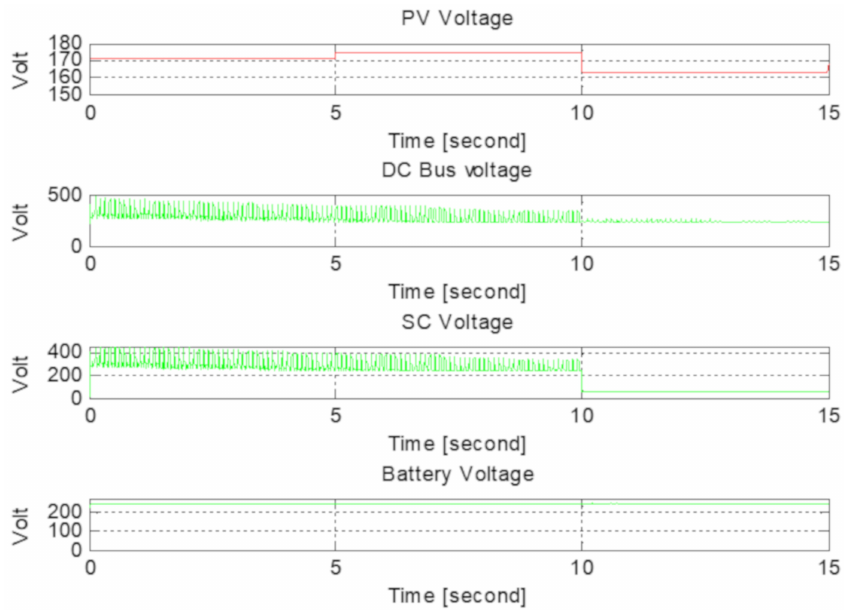
Figure 16. The simulation results of voltage variations for three di ff erent level PV